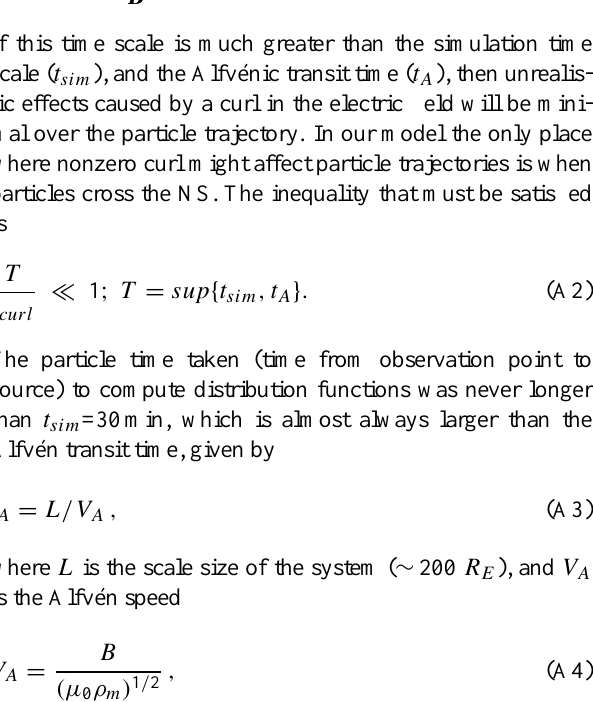
Fig. A1. Contour plot of log 10 (T/t curl ) defined in Eq. (A1). The top figure shows contours in the X − Y plane at Z = 0 R E . The bottom figure is for data computed in the X − Y plane at Z = 0 . 1 R E